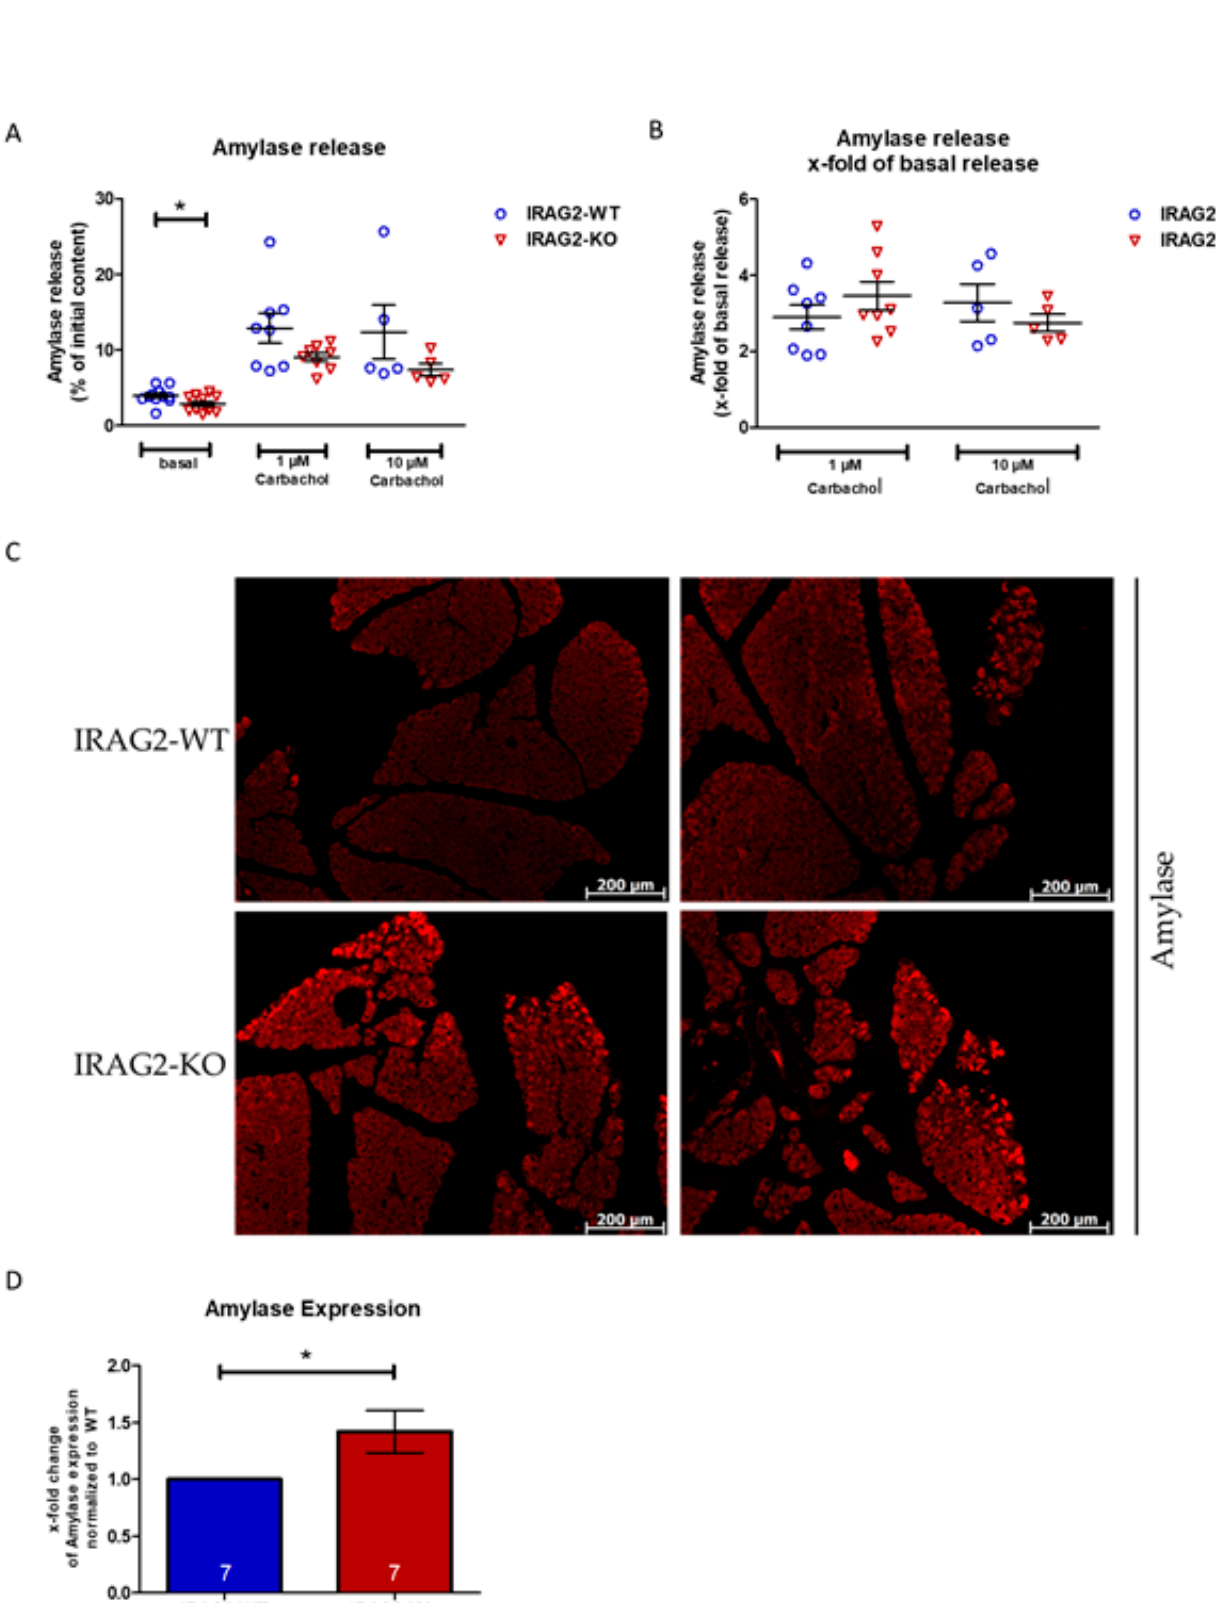
Figure 4. Amylase release in pancreatic acinar cells and Amylase content in whole murine pancreas. ( A , B ) Release of amylase was stimulated in isolated pancreatic acinar cells for 30 min using 1 µM or 10 µM carbachol or incubation buffer as control for basal release. ( A ) IRAG2-KO cells revealed a significant lower basal amylase secretion compared to IRAG2-WT (for 1 µM carbachol: WT: n = 8, KO: n = 8; for 10 µM carbachol: WT: n = 5, KO: n = 5). ( B ) Amylase release was calculated as x-fold of basal release where IRAG2-KO cells manifested a tendency for a higher amylase release x-fold of basal release upon stimulation with 1 µM carbachol but not for stimulation with 10 µM carbachol (for 1 µM carbachol: WT: n = 8, KO: